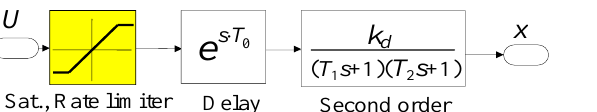
Figure 3. Nonlinear (saturation and rate limiter), simplified model of the PMS motor with the ball screw.